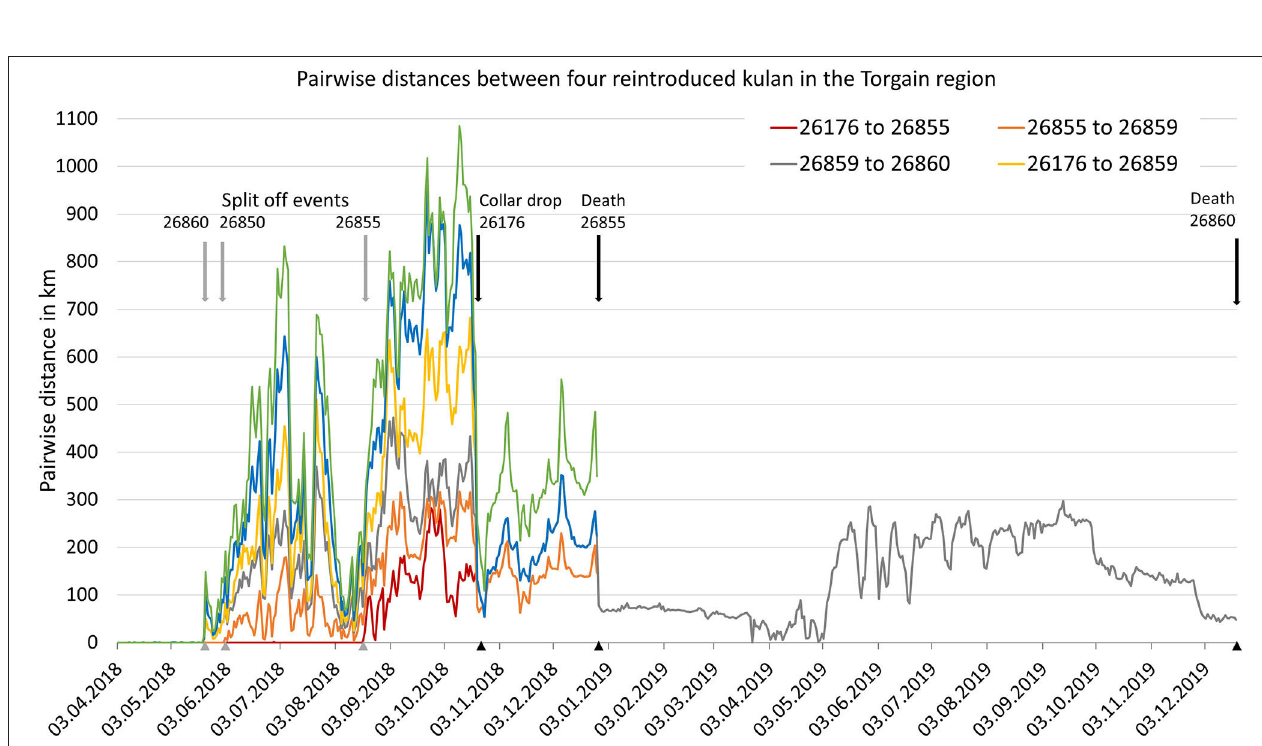
FIGURE 3 | Pairwise distances between reintroduced kulan in the Torgai region after release from the pre-release enclosure on 03.04.2017.